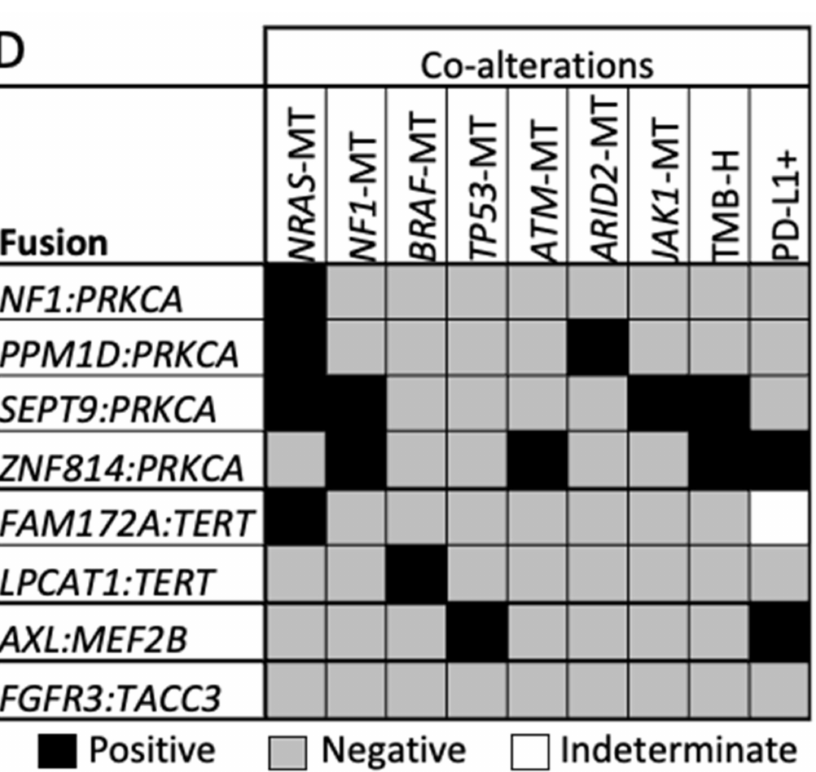
Figure 2. Oncogenic fusion schematics and co-alterations. ( A , C ) Schematics of gene fusions with known functional domains annotated. ( B , D ) Co-alterations identified in fusion-positive samples. RAS family fusions shown in ( A , B ), and fusions involving PRKCA , TERT , AXL , and FGFR3 shown in ( C , D ). * Novel